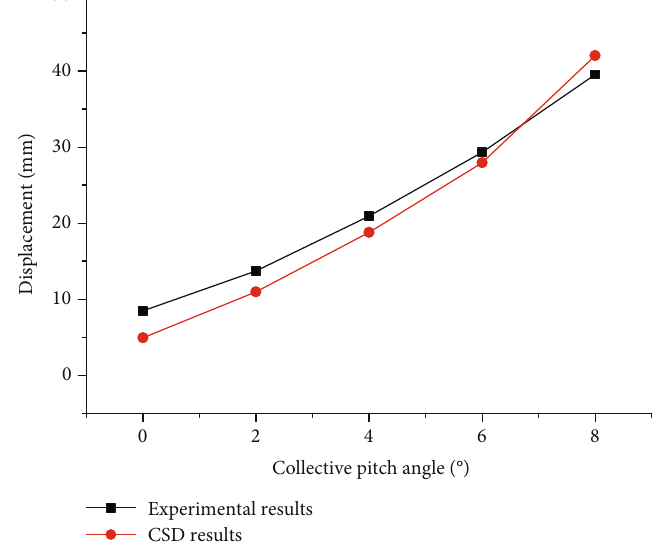
Figure 18: Comparison of the average blade tip displacements between experimental and CSD